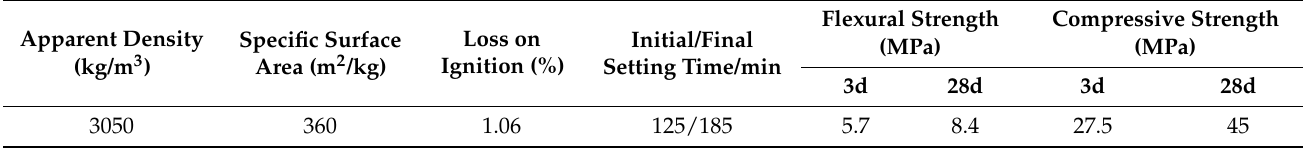
Table 1. Performance indexes of P.O.42.5R cement.